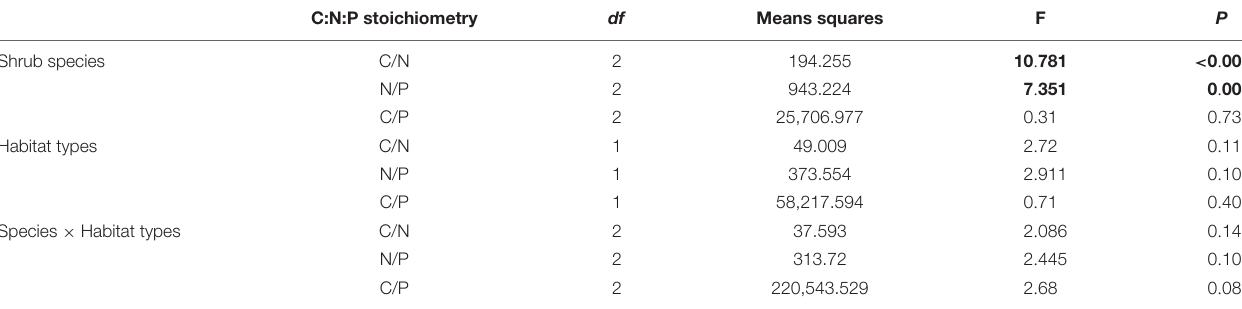
TABLE 2 | Two-way ANOVA analysis of C:N:P stoichiometry between three shrubs under heterogeneous environments. C:N:P stoichiometry df Means squares F P